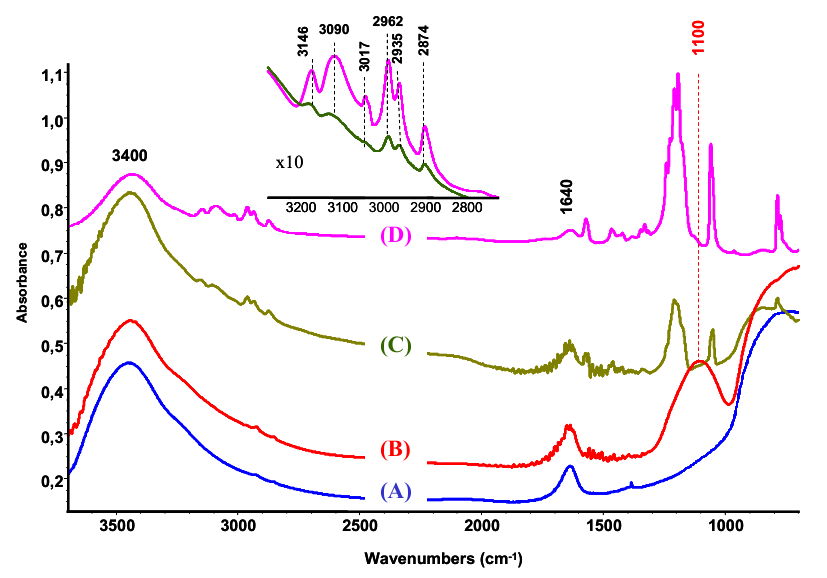
Figure 2. FTIR spectra of ( A ) bare alumina; ( B ) phosphate-modified alumina; ( C ) supported ionic liquid and ( D ) 1-butyl-3-methylimidazolium